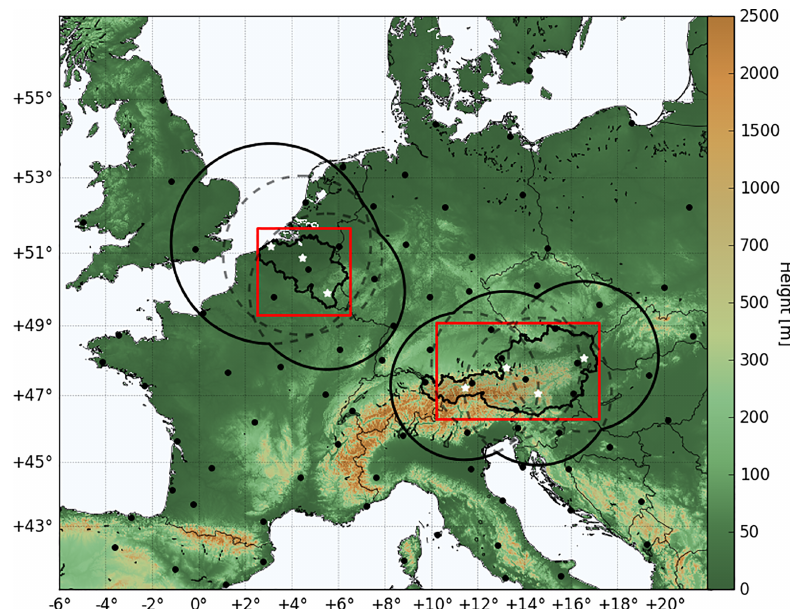
Figure 1. The locations of the EUCLID sensors in the domain are indicated (black dots), as well as the positions of the radars (white stars) together with the respective collective detection range in Belgium and Austria. The red boxes indicate the two areas that are used in this